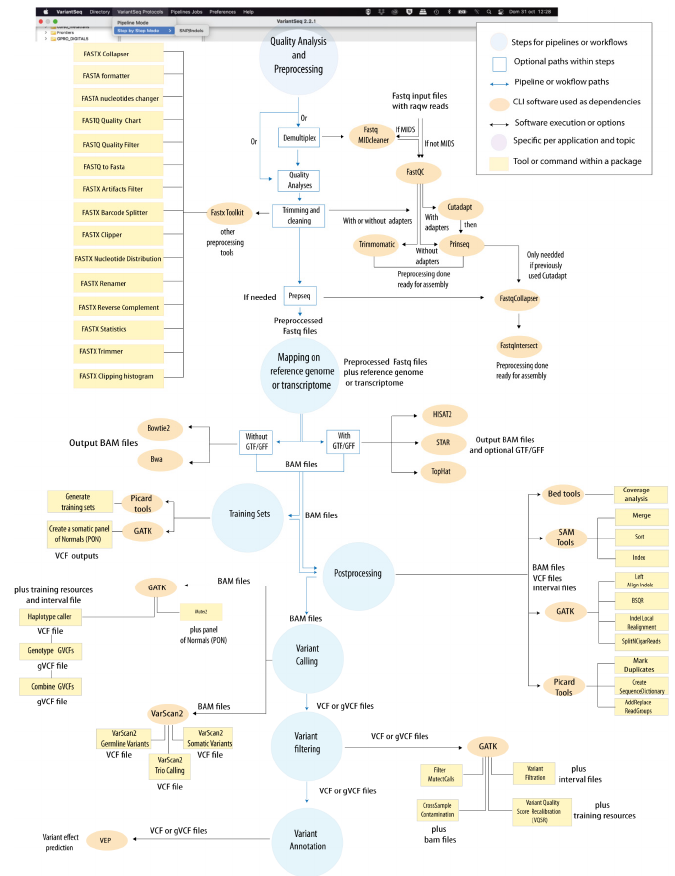
Figure 4. “ VariantSeq ” protocol . Computational steps within “ VariantSeq ” for calling and annotation of SNP and indels. This protocol is based on the following steps: “ Quality Analysis & Preprocessing ”; “ Mapping ”; “ Training Sets ”; “ Postprocessing ”; “ Variant Calling ”; “ Variant Filtering ”; and “ Annotation ”. Depending on the combination of tools selected in this protocol, users can call distinct types of variants (germinal, somatic, cancer, trio) from genome, exome, and transcriptome NGS data. In Supplementary File S3, we provide an example of GUI implemented in “ VariantSeq ” for running CLI tools. In addition, we also provide a full tutorial for “ VariantSeq ” usage in the Data Availability section of this article.